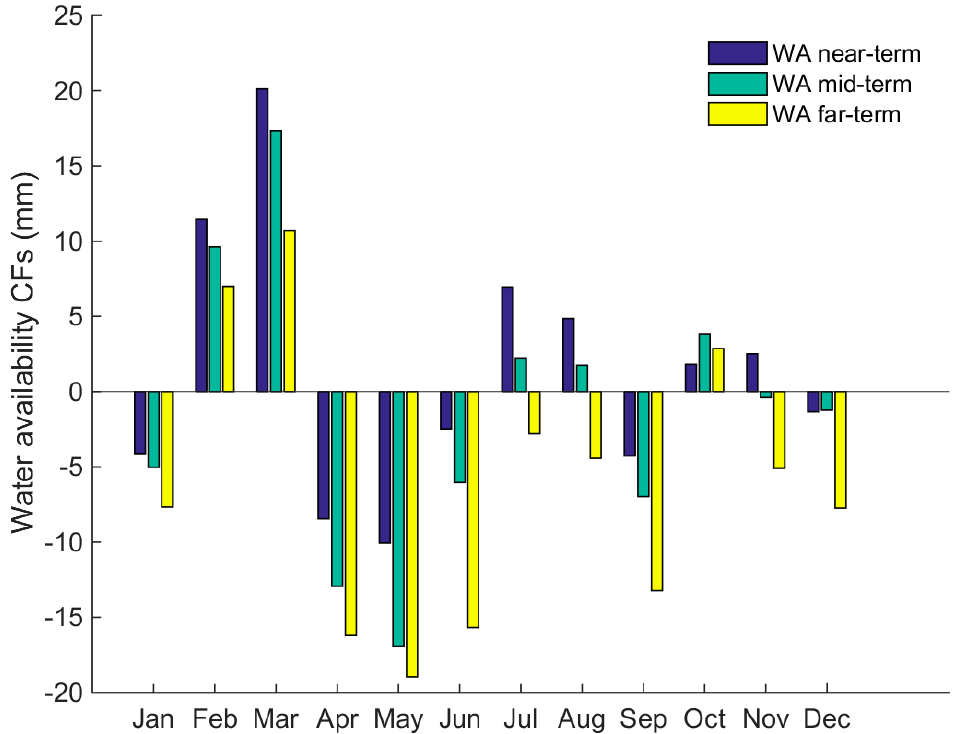
Figure 12. Water availability change factors for the future three periods.